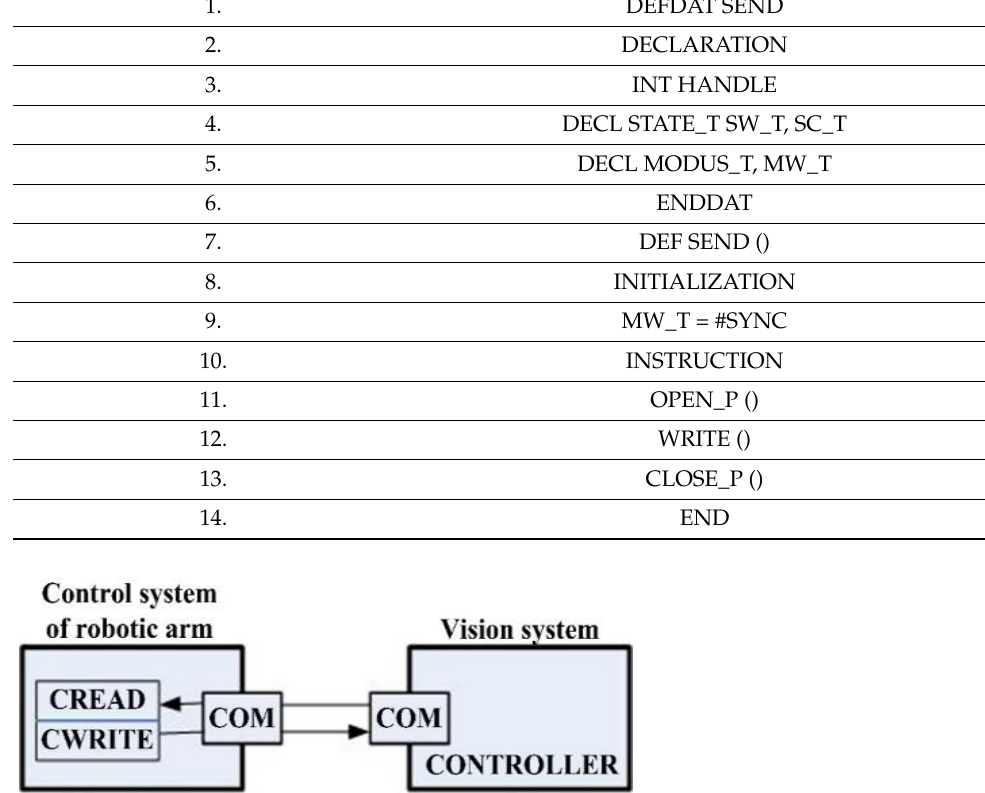
Figure 2. Composition of the sensing principle.